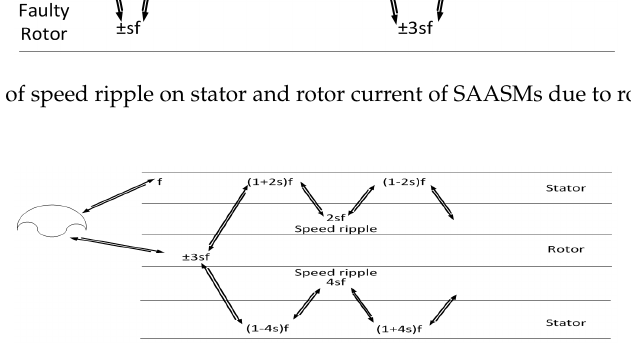
Figure 3. Effect of speed ripple on stator and rotor current of SAASMs due to saturation